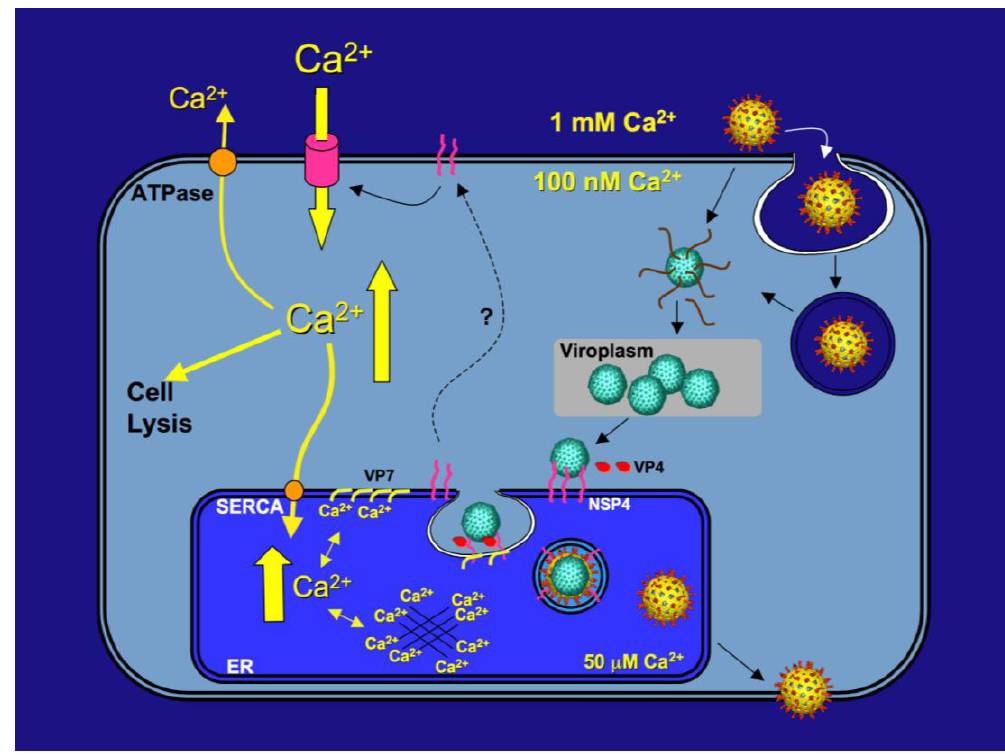
FIGURE 6. Changes in Ca 2+ homeostasis induced by rotavirus infection. It is hypothesized that NSP4 synthesized in the ER travels to the plasma membrane to form a channel or activate a cellular Ca 2+ pathway. This induces a progressive increase in plasma membrane Ca 2+ permeability, which leads to an elevation of cytosolic Ca 2+ concentration and enhancement of sequestered Ca 2+ pools in the ER. This effect is likely due to the activation of SERCA pumps. Ca 2+ may be buffered in the ER by chaperones and viral proteins (VP7), reducing the free Ca 2+ pools releasable by agonists. The elevation of cytosolic Ca 2+ concentration may be responsible for cell death induced by